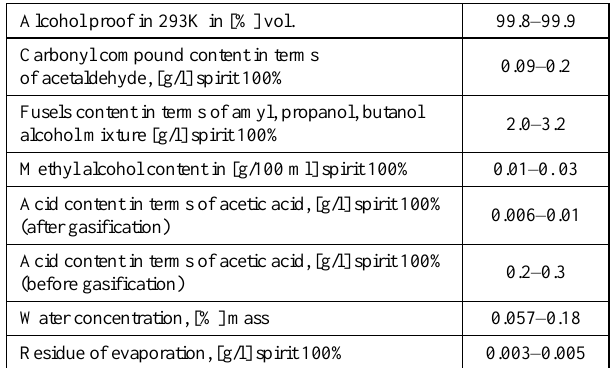
Table 4. Average content of